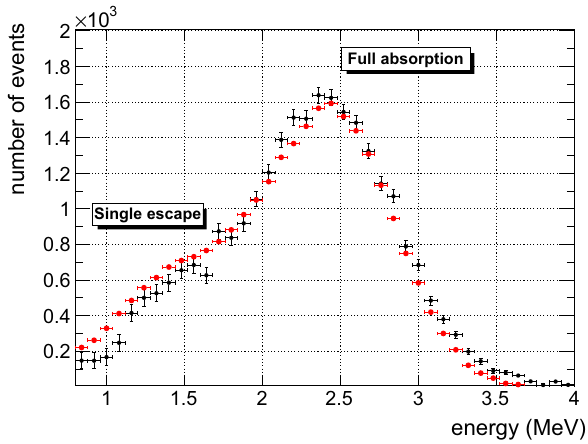
Fig. 3 Energy spectrum of signals due to neutron captures after back- ground subtraction (in black), compared with MC simulation (in